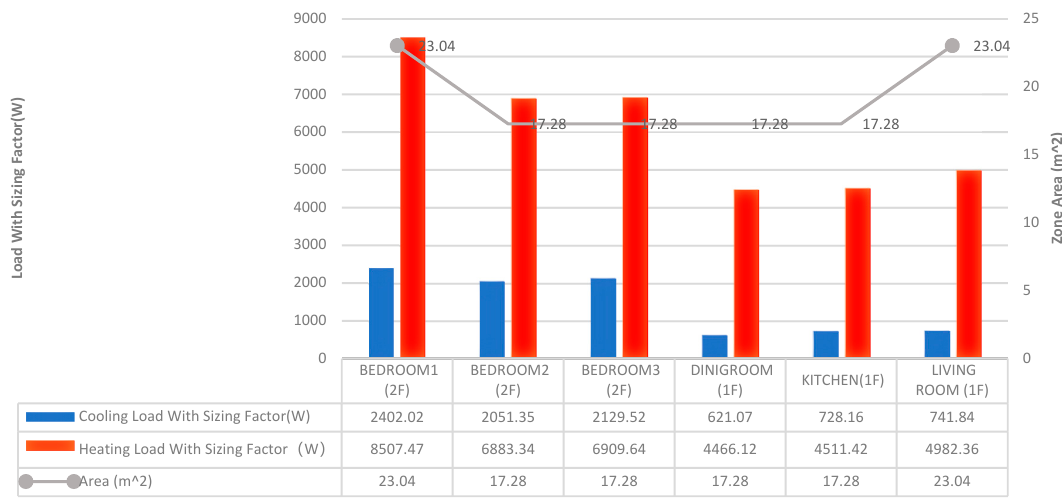
Figure 9. Cooling peak load and heating peak load of each zone, along with the sizing factor (W).